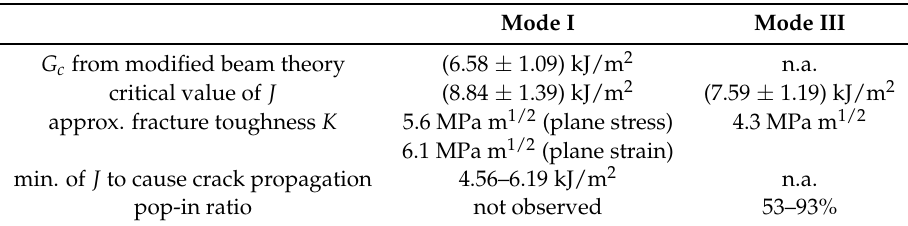
Table 2. Summary of the most important experimentally obtained